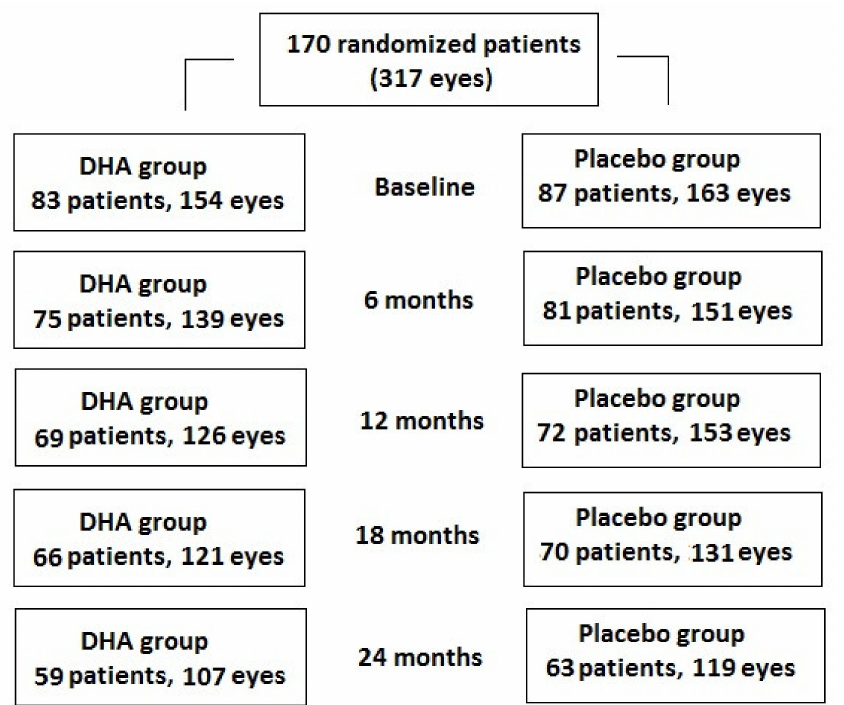
Figure 1. Distribution of patients thought the 2-year study period. Number of patients attending each follow-up visit and number of eyes